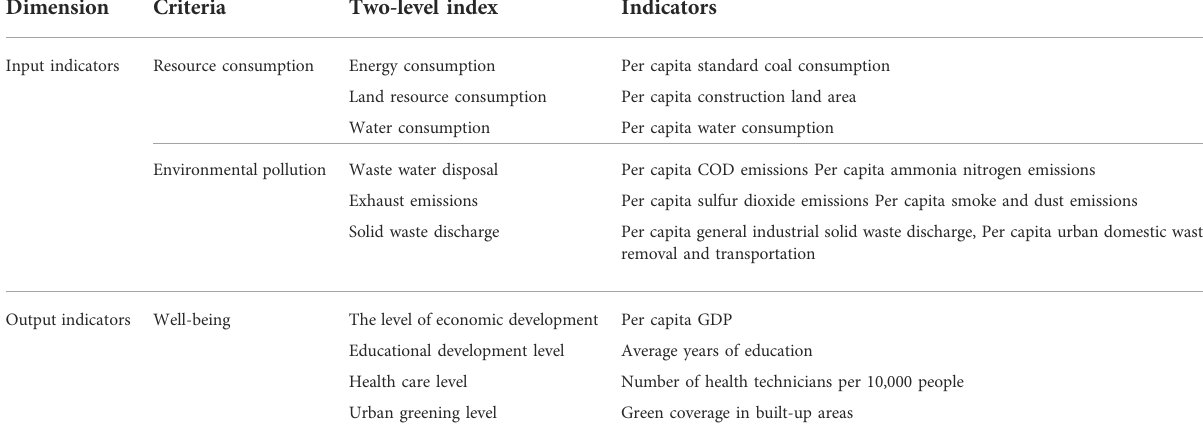
TABLE 2 The evaluation index system of